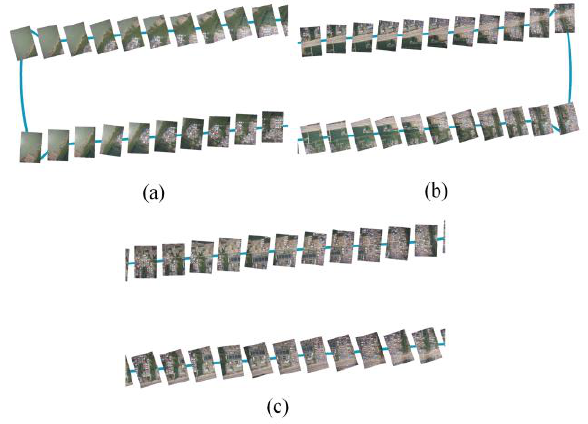
Figure 3. Parts of tracking map with thumbnail photos rotated. (a), (b) and (c) shows the details in track map with images rotated according to yaw angles calculated when initial image network generation in Case